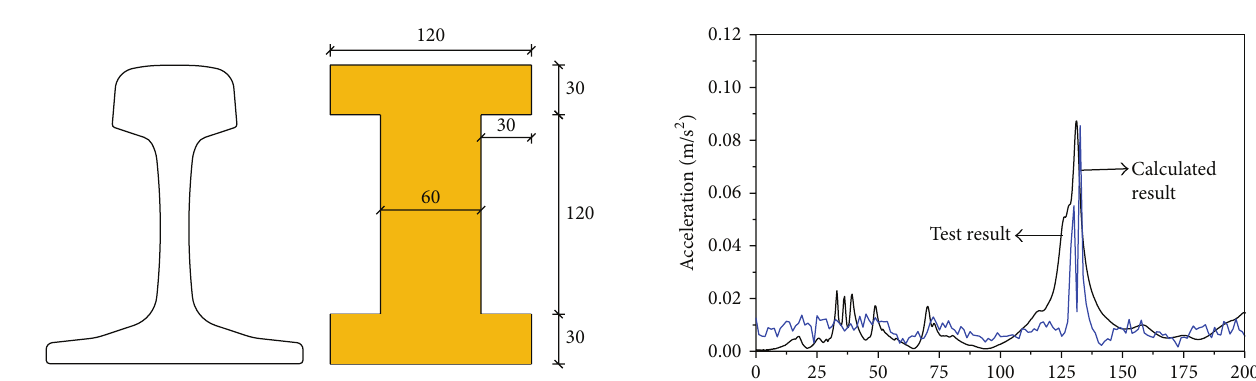
Figure 7: Simplified cross section of the rail (unit: mm).